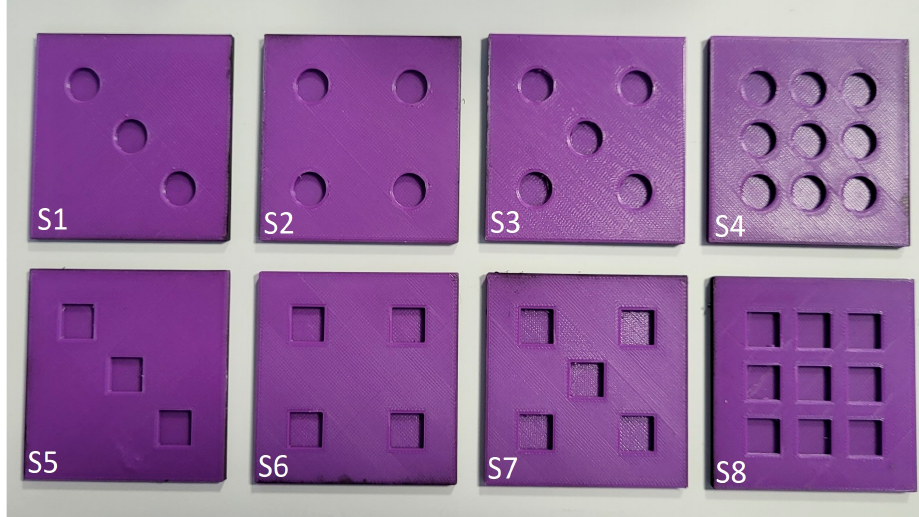
Figure 1. Test samples.